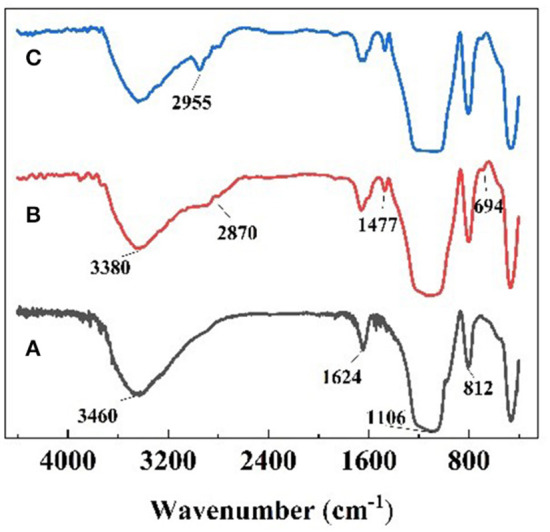
FT-IR spectra of (A) raw SiO2, (B) modified SiO2, and (C) responsive nano-SiO2.